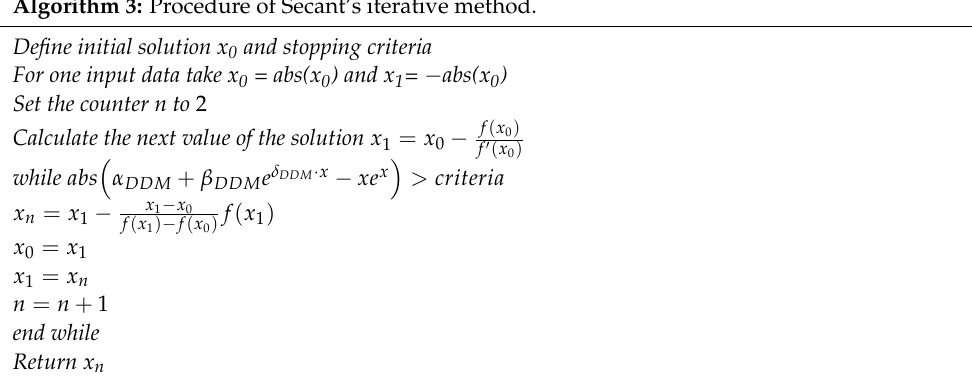
Algorithm 3: Procedure of Secant’s iterative method.